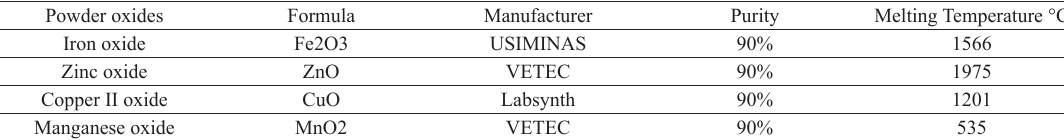
Table 1. Summary of oxides used in the production of oxide powders.